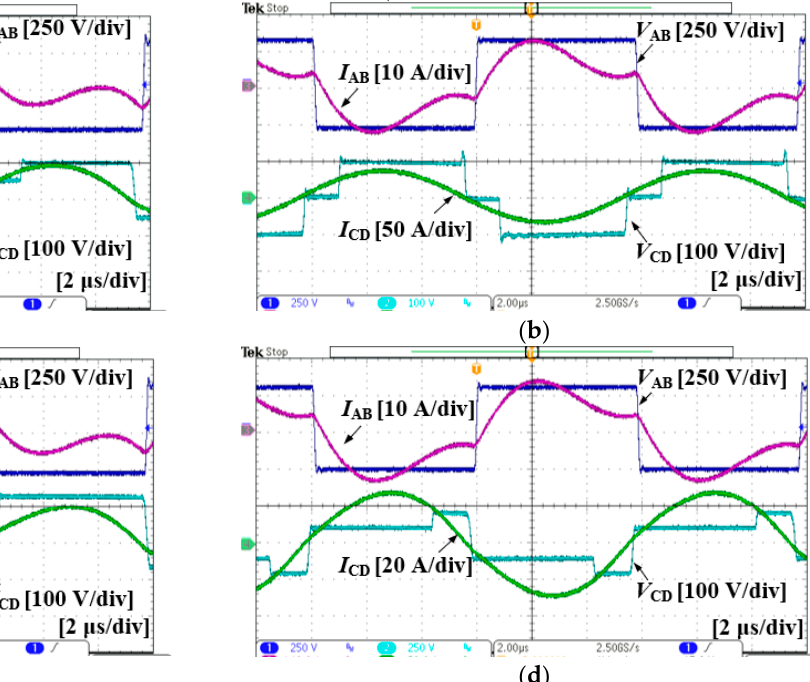
Figure 8. Measured waveforms of inverter and rectifier: ( a ) V O = 100 V, k = 0.16; ( b ) V O = 200 V, k = 0.16; ( c ) V O = 100 V, k = 0.23; ( d ) V O = 200 V, k = 0.23.